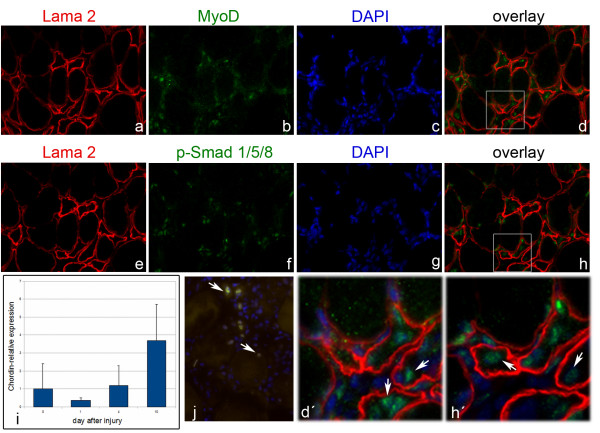
Activated BMP signaling during muscle regeneration. Parallel section ((A-D) and (E-H) represent images of 2 parallel sections) of the regenerating gastrocnemius muscle 4 days after injury were analyzed for Lama (A,E), MyoD (B) and p-Smad (F). Nuclei are stained with DAPI (C,G). Boxed areas in the overlay images (D,H) are enlarged in (D',H'). Both, MyoD (A-D,D') and p-Smad-positive nuclei (E-H,H') are located beneath the basement lamina of regenerating myofibers (white arrows in D',H'). (J) Double immunostaining of MyoD, detected with a goat anti-MyoD antibody (green), and p-Smad, detected with a rabbit anti-p-Smad antibody (red), revealed co-localization of both proteins in a subset of nuclei (yellow, arrows) in the regenerating tissue. Nuclei were counterstained with DAPI (blue). Magnification is 400×. (I) Analysis of Chordin expression by RT-PCR shows highest expression levels after 10 days of injury (n = 6 control animals, n = 2 animals at day 1 and n = 3 animals at day 4 and day 10).